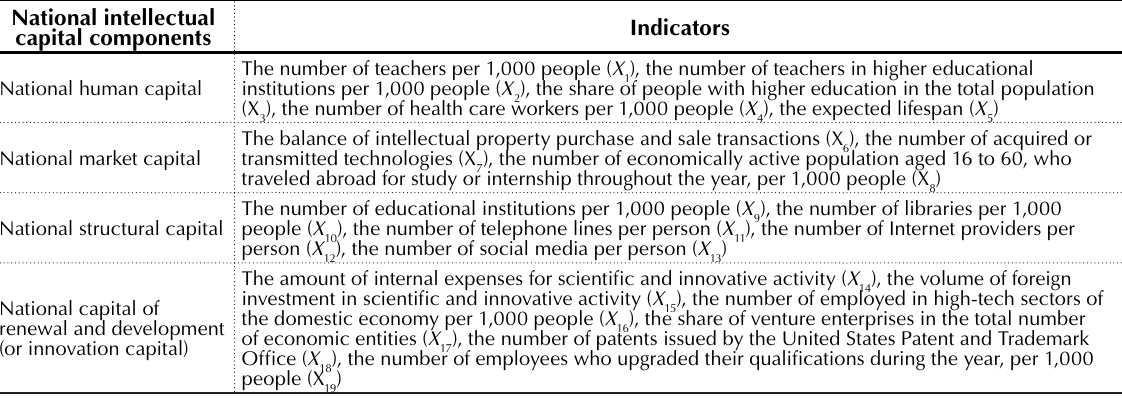
Table 2. Indicators characterizing the components of national intellectual capital National intellectual capital components Indicators National human capital